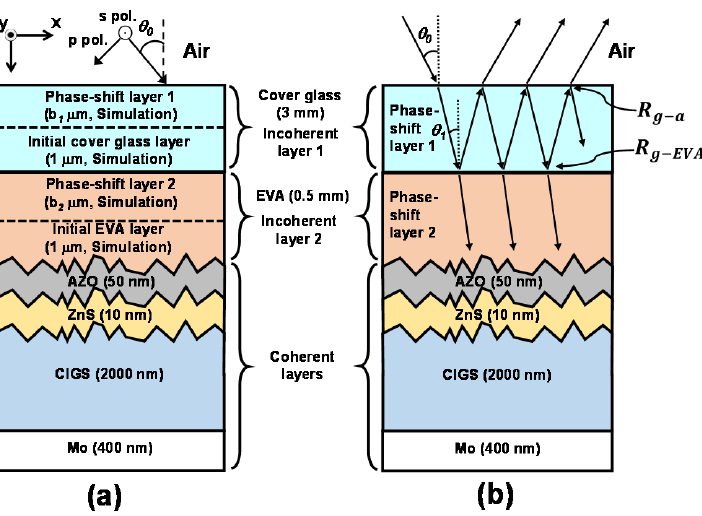
Figure 6. ( a ) Schematic diagram of the surface-textured CIGS solar cell. Because the 3 mm cover glass and the 0.5 mm EVA flattening layers are transparent, they are modelled as the 1 µ m thick initial layer plus the respective phase-shift layer whose thicknesses b 1 and b 2 are determined based on Equation (4) in the ADETAM-based calculation. The interfaces of the EVA/AZO/ZnS/CIGS multilayer are assumed to be randomly textured with the RMS surface roughness, which varies as σ RMS = 25, 50, 75, and 100 nm. ( b ) Incoherent multiple optical reflections inside the planar incoherent cover glass layer to determine the minimum reflectance of the surface-textured CIGS solar cell. The reflectance from the cover glass to the air is R g-a and the reflectance from the cover glass to the EVA